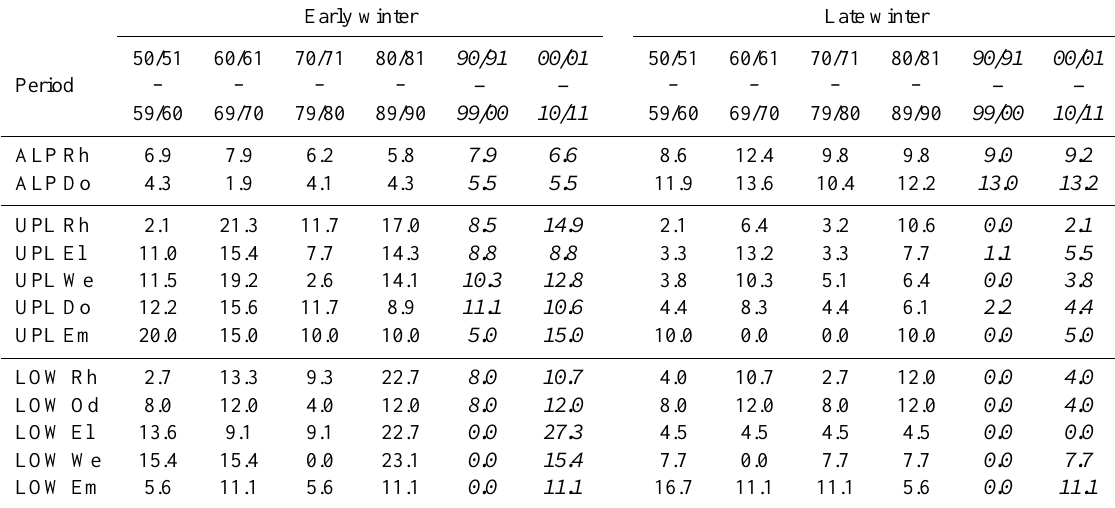
Table 2. Percentage of RoS events (1950–2011) in each sub-basin that occurred during time slices of 10years during the early and late winter seasons. The italicised columns highlight the period 1990–2011, thus corresponding to the short-term trend analysis performed for RoS